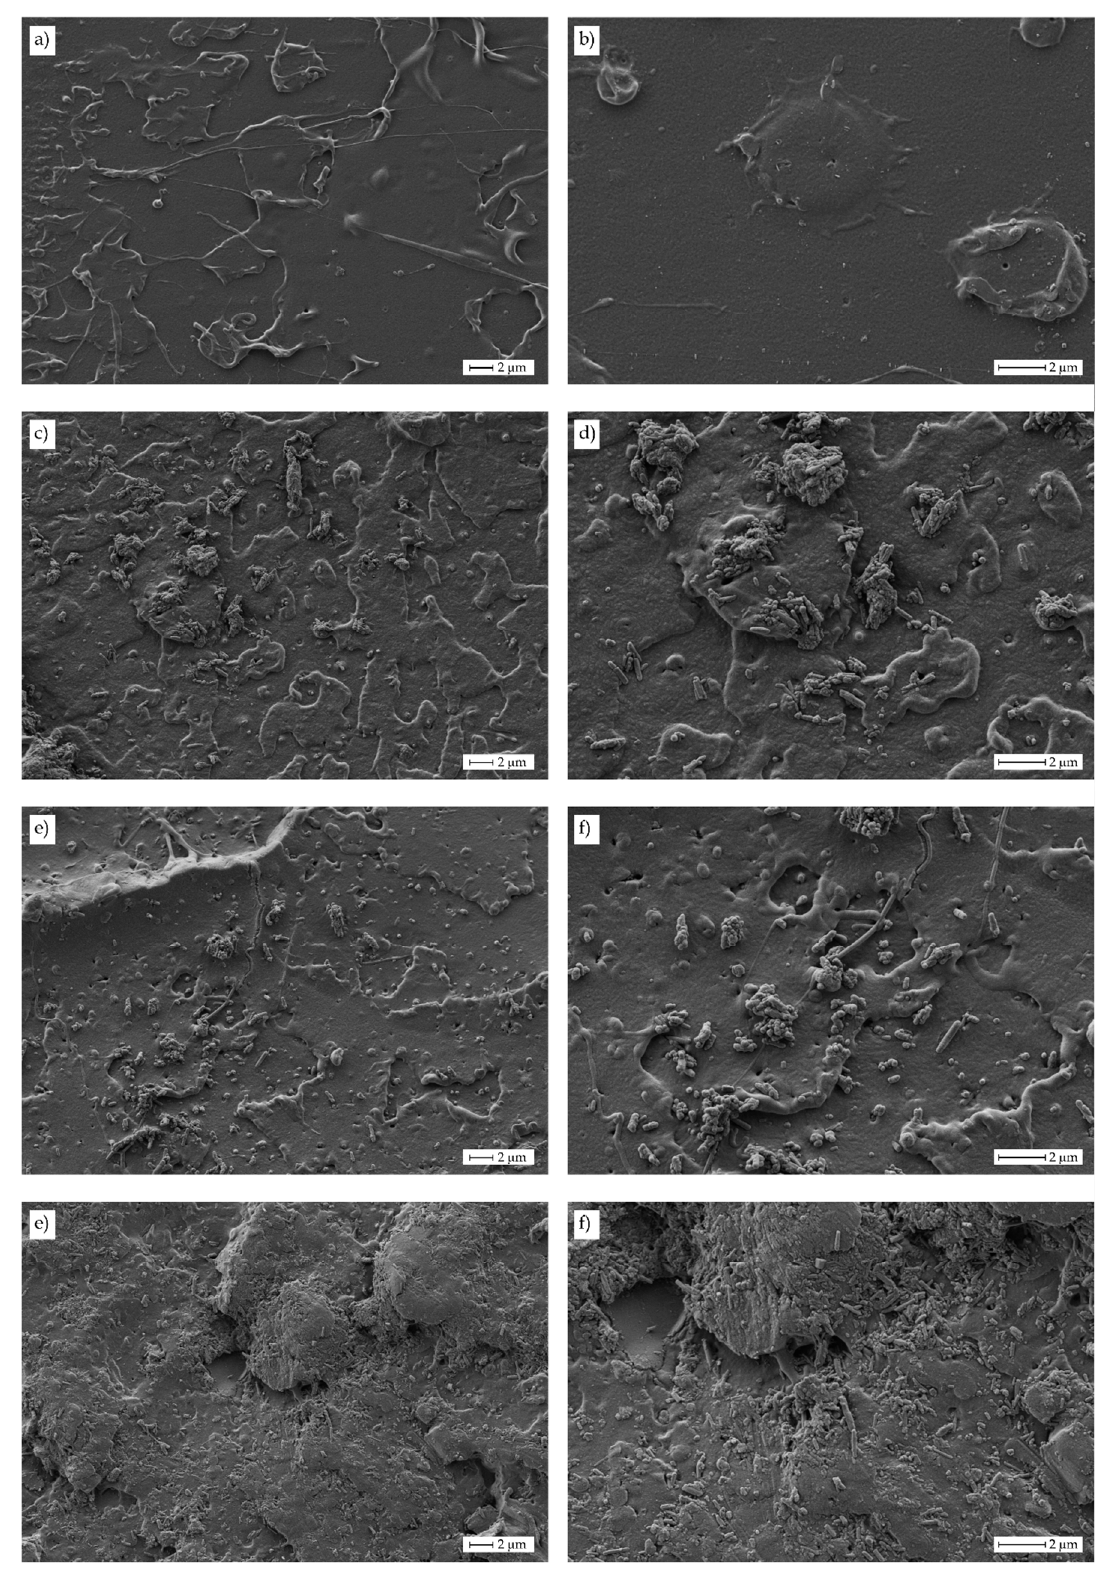
Figure 3. Field emission scanning electron microscopy (FESEM) images at different magnifications (2500 × : left column; 5000 × : right column) of fractured samples from impact tests corresponding to PLA-HNT composites with different HNTs loading. ( a ) and ( b ) neat PLA, ( c ) and ( d ) 3 wt% HNTs, ( e ) and ( f ) 6 wt% HNTs and ( g ) and ( h ) 9 wt % HNTs.